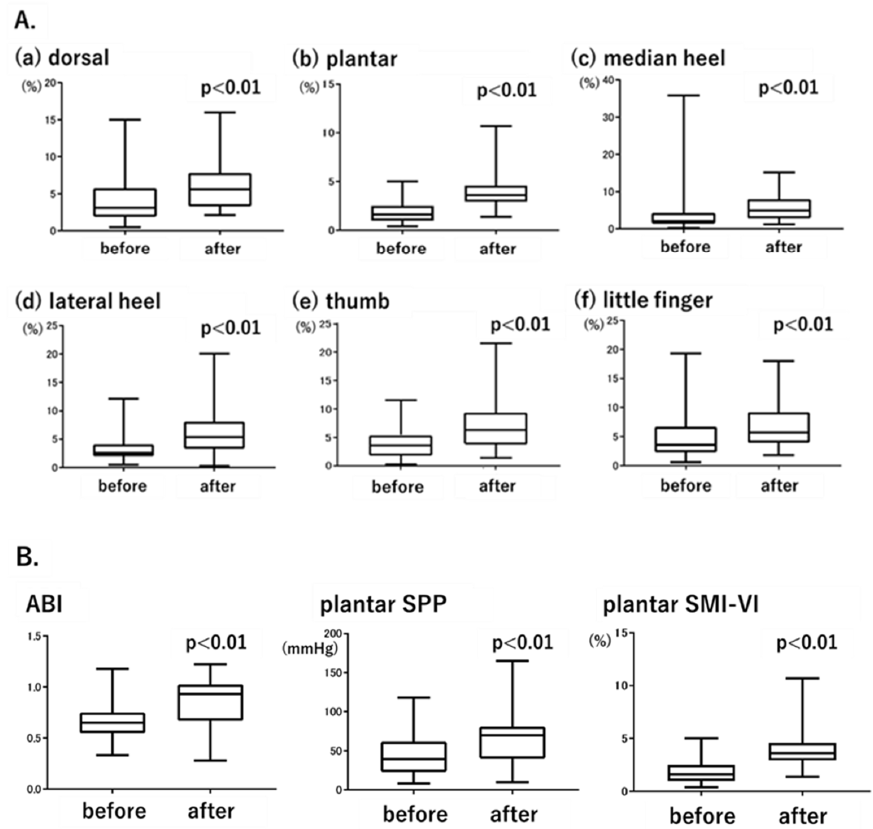
Figure 3. ( A ). Changes in SMI ‐ VI values before and after endovascular treatment (EVT). ( B ). Changes in the ABI, plantar SPP, and plantar SMI ‐ VI before and after EVT. Both the ABI and SPP were measured before and after EVT; the results were compared with those based on the SMI ‐ VI. For SPP and the SMI ‐ VI, plantar measurement data were used to ensure consistency with the ABI. Figure 3B shows the changes in ABI, plantar SPP, and plantar SMI ‐ VI values before and after EVT. The ABI increased from 0.62 ± 0.15 to 0.85 ± 0.25 ( p < 0.01), plantar SPP increased from 40.6 ± 21.9 mmHg to 60.3 ± 25.1